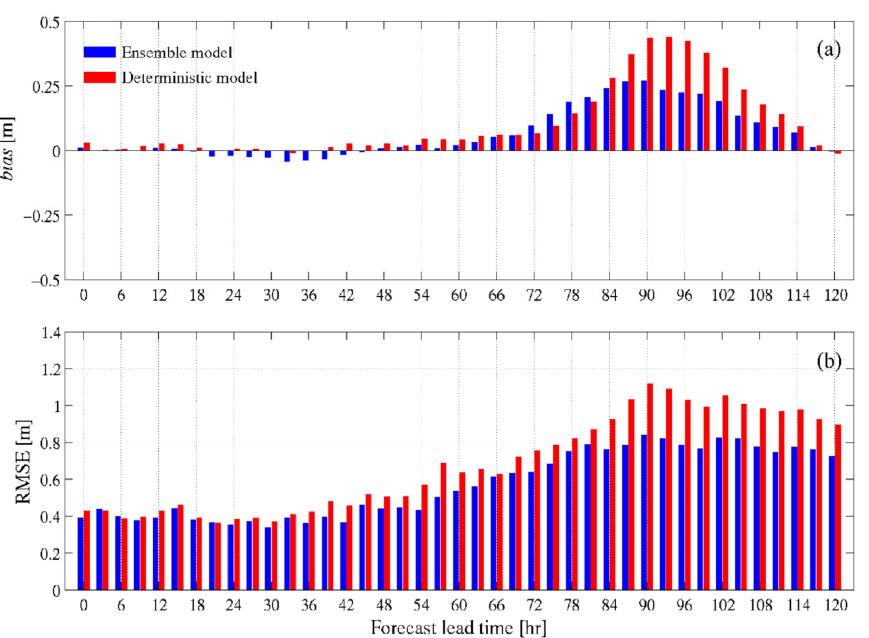
Figure 8. ( a ) bias and ( b ) RMSE for significant wave heights of ensemble model and deterministic model by forecast lead time (Analysis period: 00 UTC 1 September 2019, to 12 UTC 9 September 2019).